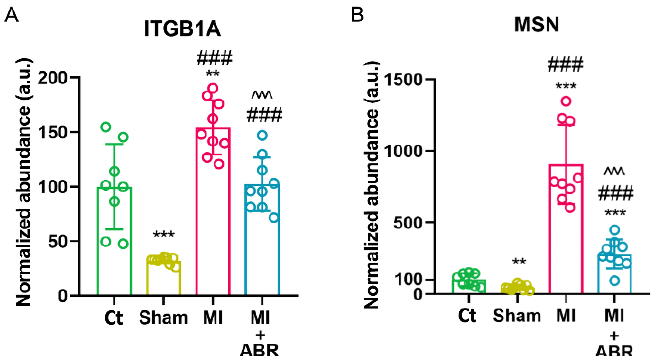
Figure 3. S100A9 blockade lowers the level of leukocyte cell–cell adhesion molecules in the infarcted myocardium on day 3 post-MI. Normalized spectral abundance of ( A ) ITG β 1A and ( B ) MSN in the left ventricle for controls (Ct, Sham), PBS-treated (MI) and ABR-treated (MI + ABR) infarcted mice. Data are presented as mean ± SD; ITG β 1A, integrin beta-1 isoform A; MSN, moesin; ** p < 0.01, *** p < 0.001 vs. Ct; ### p < 0.001 vs. Sham; ^^^ p < 0.001 vs. MI; p values were calculated using Student’s t test.